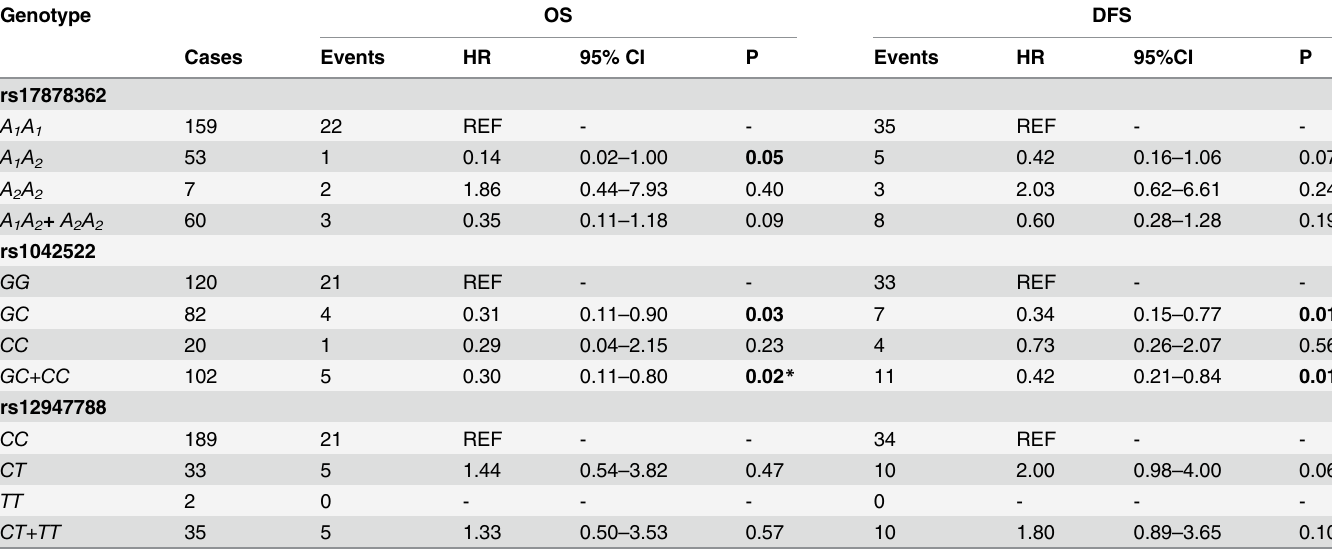
Table 5. OS and DFS in relation to SNP distributions in patients treated with anthracycline-based chemotherapy (Cox regression). Genotype OS Cases